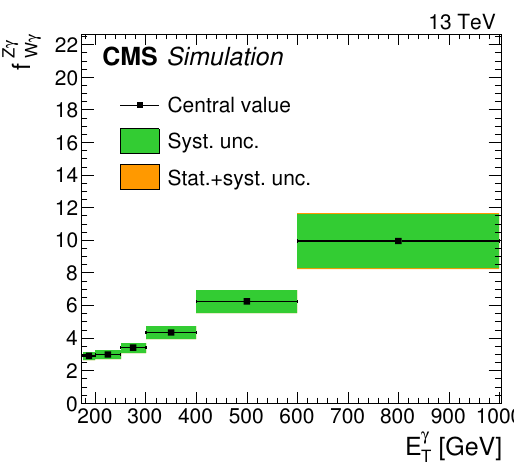
Figure 4 . Transfer factor f Z (cid:13) . The uncertainty bands in green (inner) and orange (outer) show the W (cid:13) systematic uncertainty, and the combination of systematic and statistical uncertainty arising from limited MC sample size, respectively. The systematic uncertainties considered are the uncertainties from higher-order theoretical